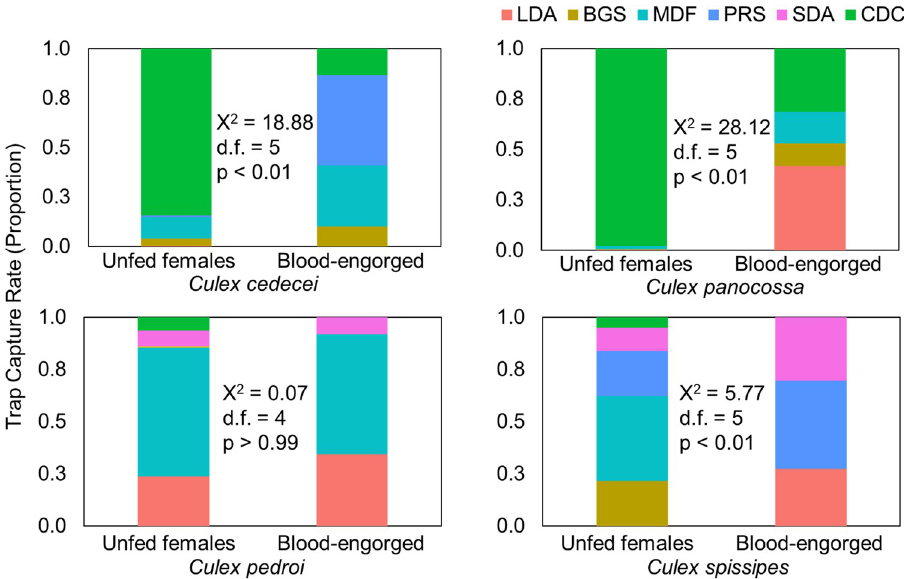
Fig 4. Relative proportions of unfed and blood-engorged Spissipes section mosquitoes. Mosquitoes were collected using the large diameter aspirator (LDA), BG-Sentinel (BGS), CDC miniature light trap (CDC), mosquito drift fence (MDF), pop-up resting shelter (PRS), and the small diameter aspirator (SDA) in Darie´n, Panama, and Florida City, FL. Chi-squared values represent differences in trap efficacy between unfed and blood-engorged of the same species.